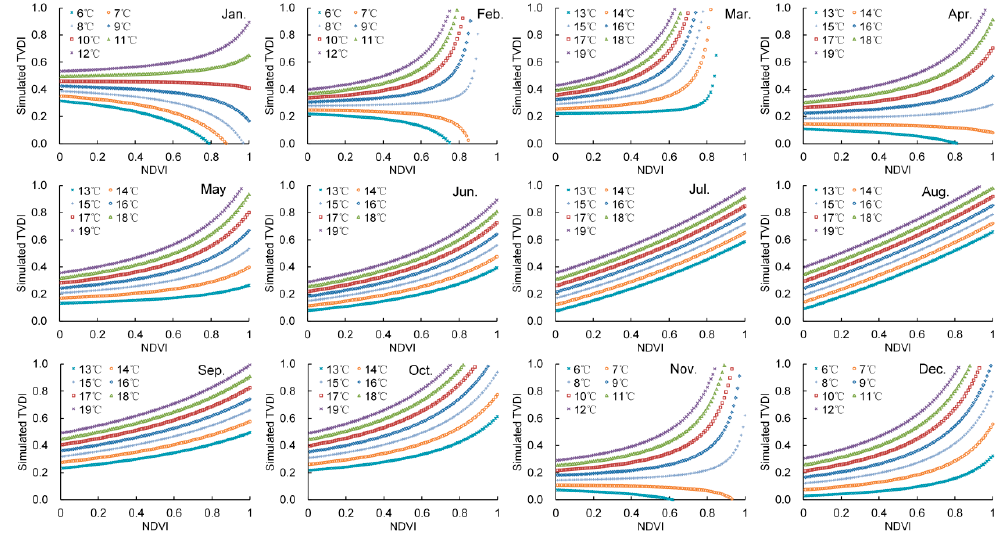
Figure 7. The simulated TVDI based on the original dry/wet edges in 2005.